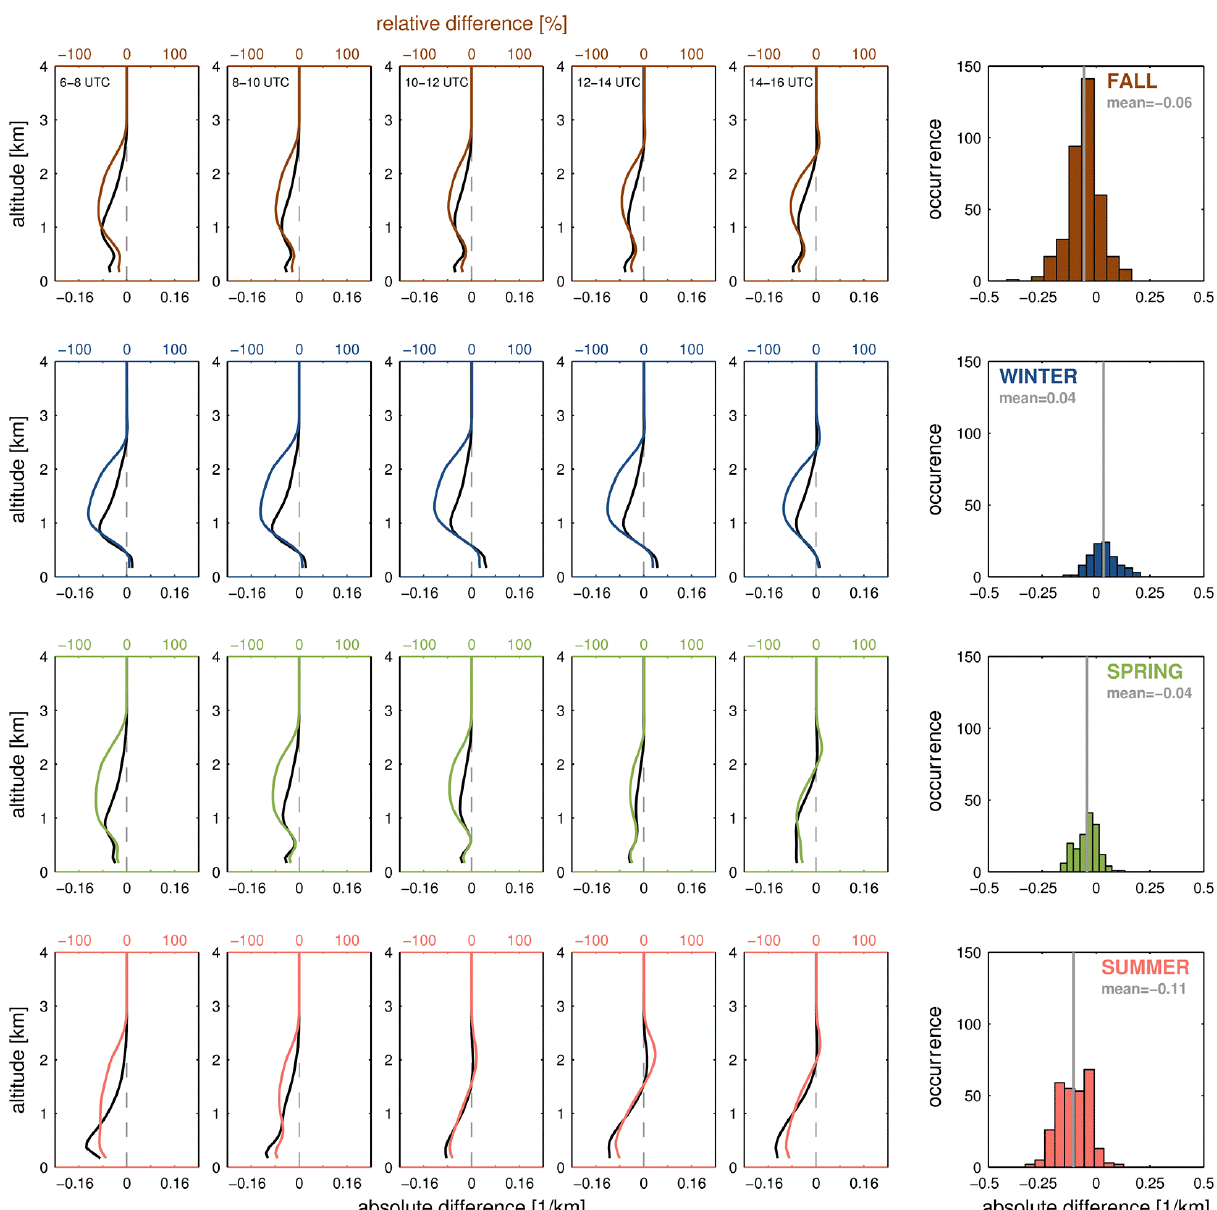
Figure 7. Absolute (black solid lines, lower axis) and relative (color-coded lines, upper axis) differences of averaged profiles obtained in the UV channel (MAX-DOAS: 338–370nm, ceilometer: 360nm). The distribution of absolute differences of near-surface AE for the different seasons is shown in the right panels. Data of cloud-free days as defined in Sect. 2.2.4 between 1 September 2017 and 31 August 2019 are